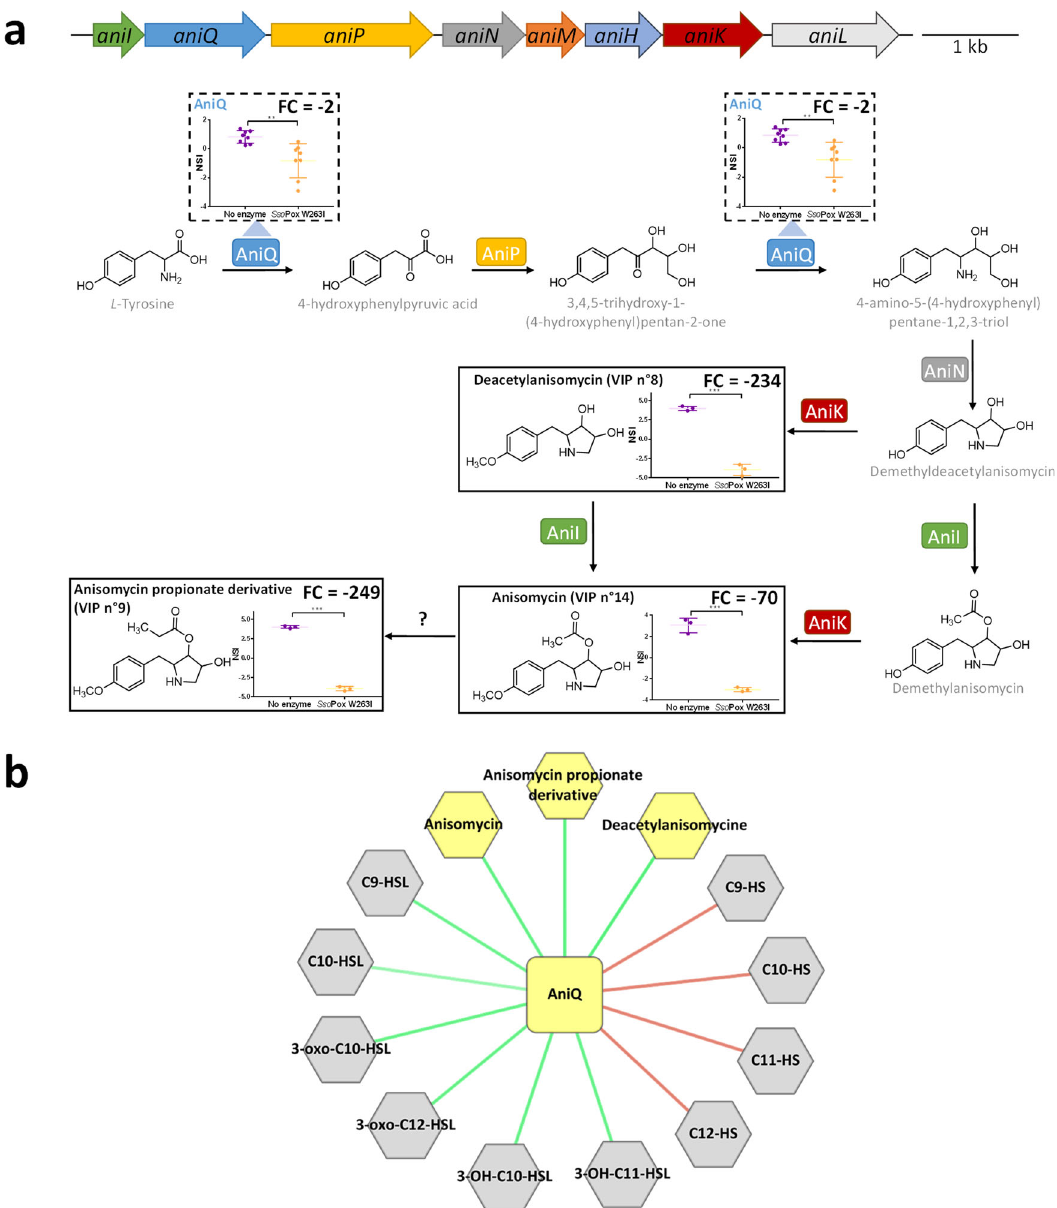
Fig. 7 Impact of Sso Pox W263I on anisomycin biosynthesis in C. violaceum . a Organization of the anisomycin biosynthesis operon and impact of Sso Pox W263I on the anisomycin biosynthetic pathway. In operon representation, arrows indicate the direction of transcription. Pathway and nomenclature are from Zheng et al. 41 . Proteins (dashed line boxes) and metabolites (full-line boxes) normalized scaled intensities (NSI) are represented as the mean and standard deviations (metabolomic: n = 3 biological replicates, proteomic: n = 8, 4 biological replicates × 2 technical replicates). * P value <0.05, ** P value <0.01, *** P value <0.001 according to Student ’ s t test. FC fold change. b Correlation multi-omics network of the protein AniQ (square) and metabolites (hexagons) involved in the production of anisomycin. Metabolites signi fi cantly impacted by Sso Pox W263I are positively (green) or negatively (red) connected with